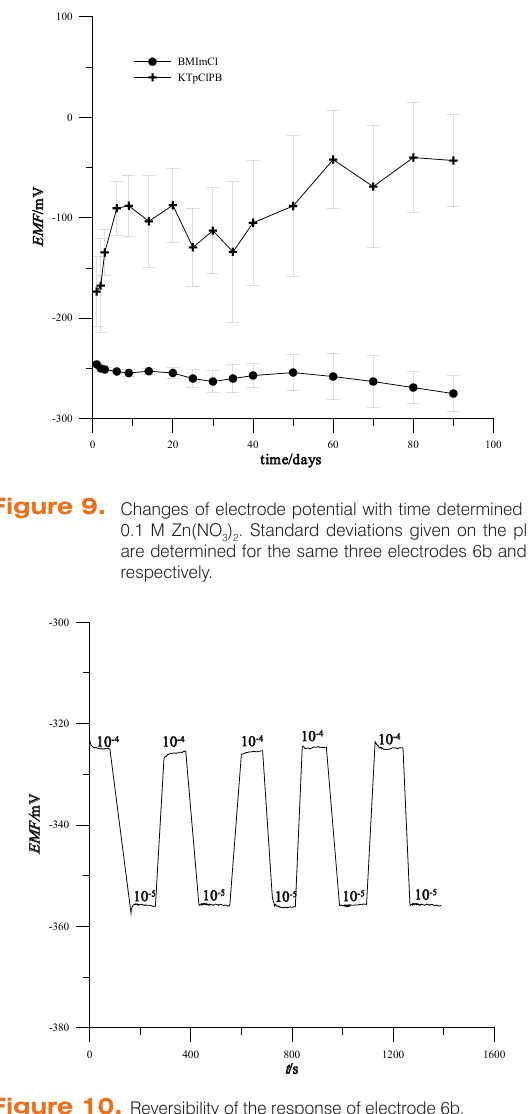
Figure 10. Reversibility of the response of electrode 6b.